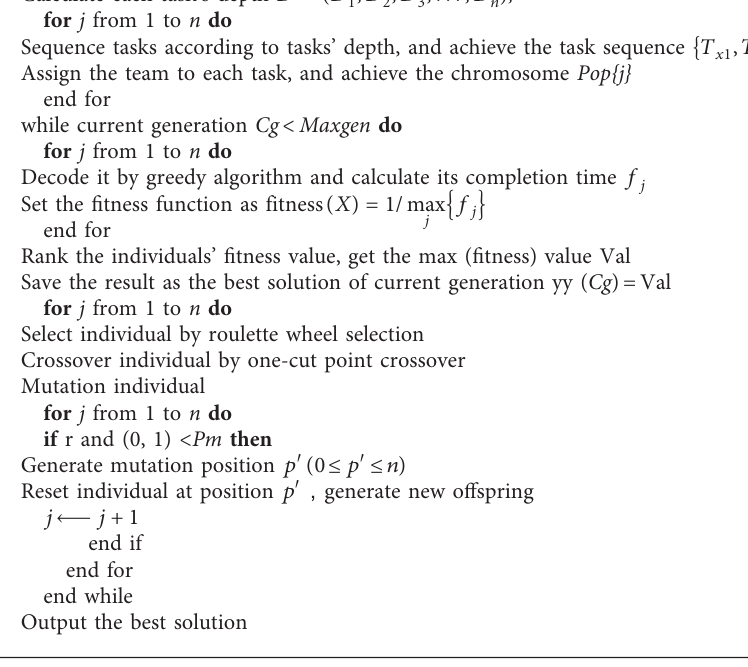
Table 4: The effective similar task set for T